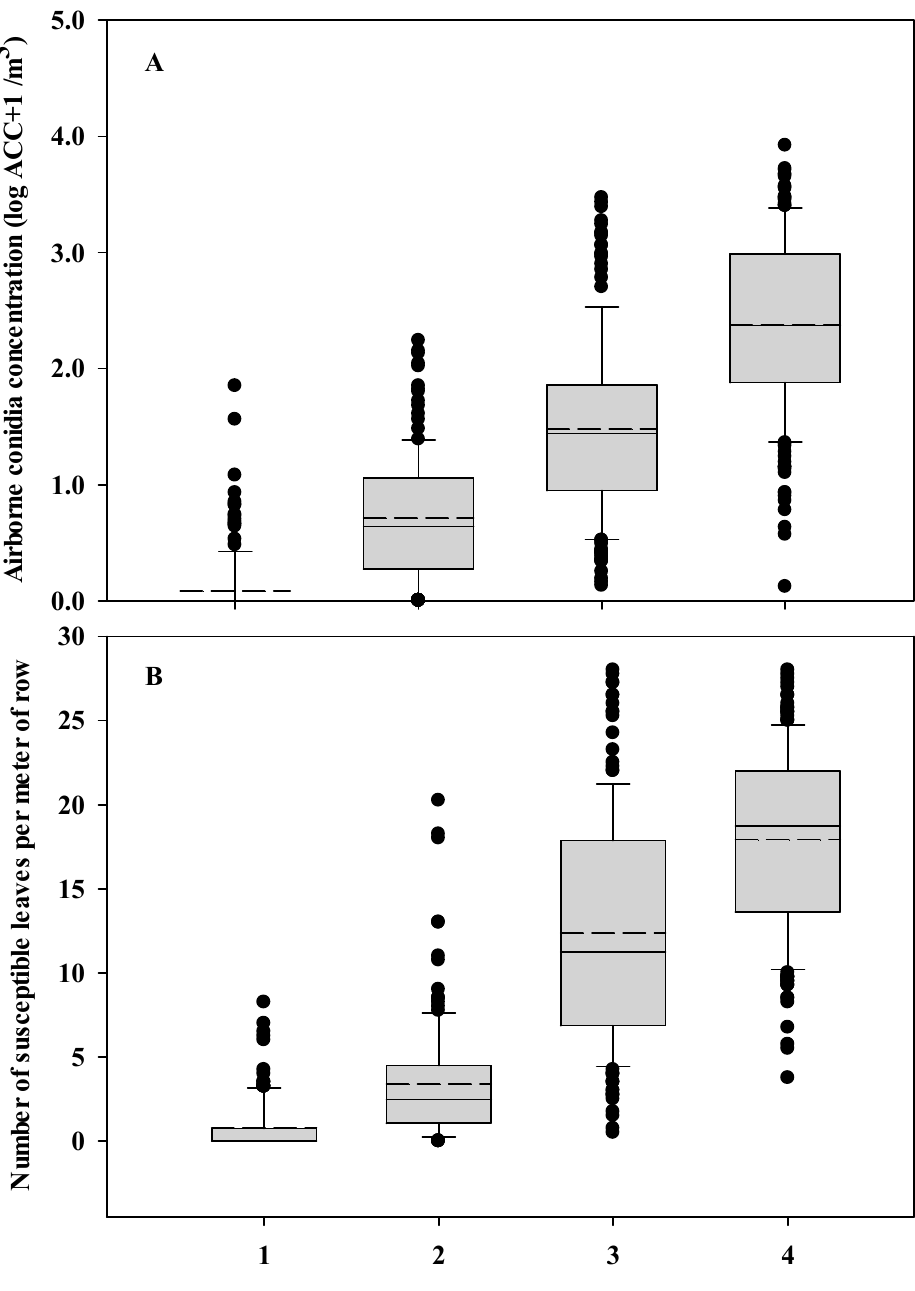
Figure 2. Distribution of airborne inoculum concentrations ( A ) and number of susceptible leaves ( B ) corresponding to the four classes of strawberry powdery mildew. Classes are 1: PLAD = 0; 2: PLAD > 0 and ≤ 5%; 3: >5% and ≤ 15%; and 4: PLAD > 15%, where PLAD is the proportion of leaf area diseased. For each boxplot, from bottom to top, except for the thicker line and whisker caps, each horizontal line marks 25%, 50%, and 75% of data points, respectively. The dashed horizontal line is the mean value and black circles are outliers.